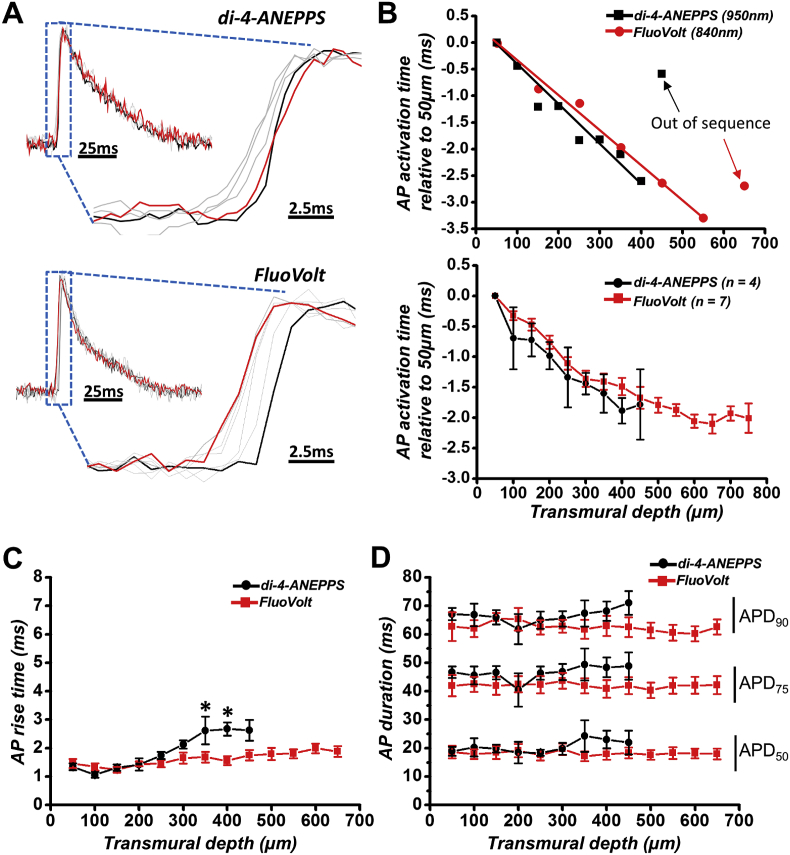
Transmural cardiac electrophysiology using FluoVolt. (A) Representative AP traces from sequential transmural layers in isolated hearts loaded with di-4-ANEPPS (upper panel) or FluoVolt (lower panel). Hearts are paced from the endocardial surface to generate endo-epi conduction patterns. Red AP profiles indicate the deepest transmural layer, black AP profiles indicate surface layers, and grey AP profiles indicate intermediate layers. (B) Top panel - Activation timing of each layer shown in (A) relative to the surface layer. Deepest layers for both dyes are eventually out of sync with the endo-epi activation pattern. Bottom panel - Average activation timing relative to surface layer of FluoVolt (n = 7) and di-4-ANEPPS (n = 4) loaded hearts. (C) Average 10–90% upstroke rise time and (D) AP duration (APD) at 50, 75 and 90% repolarization obtained from each transmural layer investigated. *P < 0.05, Student's unpaired t-test.